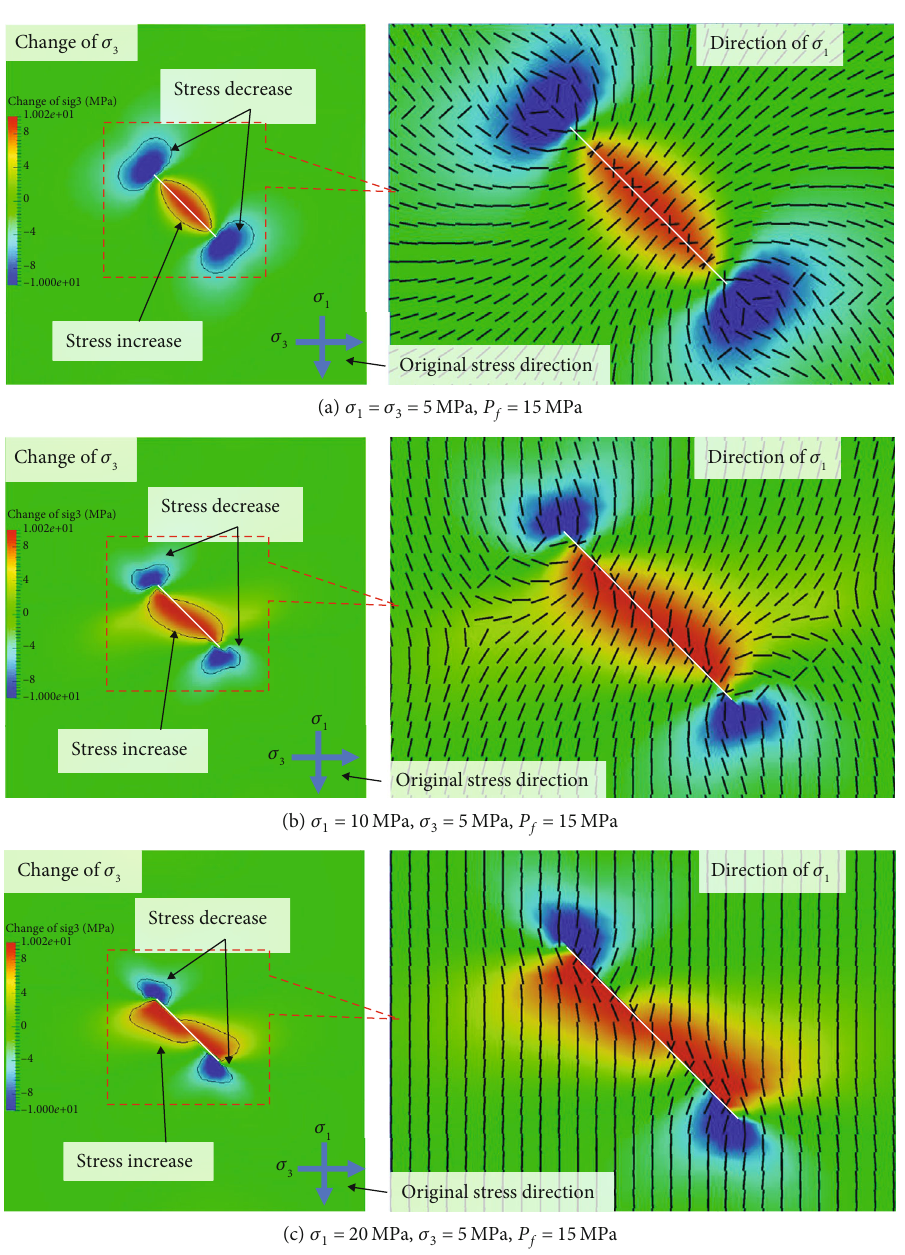
Figure 3: Stress distribution and orientation around a pressurized fracture under di ff erent stress